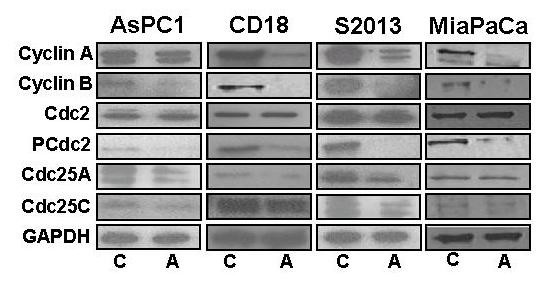
Effects of apigenin on proteins involved in the G2/M cell cycle phase transition. Expression of both cyclin A and cyclin B were both decreased in apigenin-treated cells compared to controls. While the expression of the cdc2 protein was unchanged, levels of phosphorylated cdc2 were decreased in treated cells. Expression of cdc25A and cdc25C were also decreased in treated cells compared to controls.